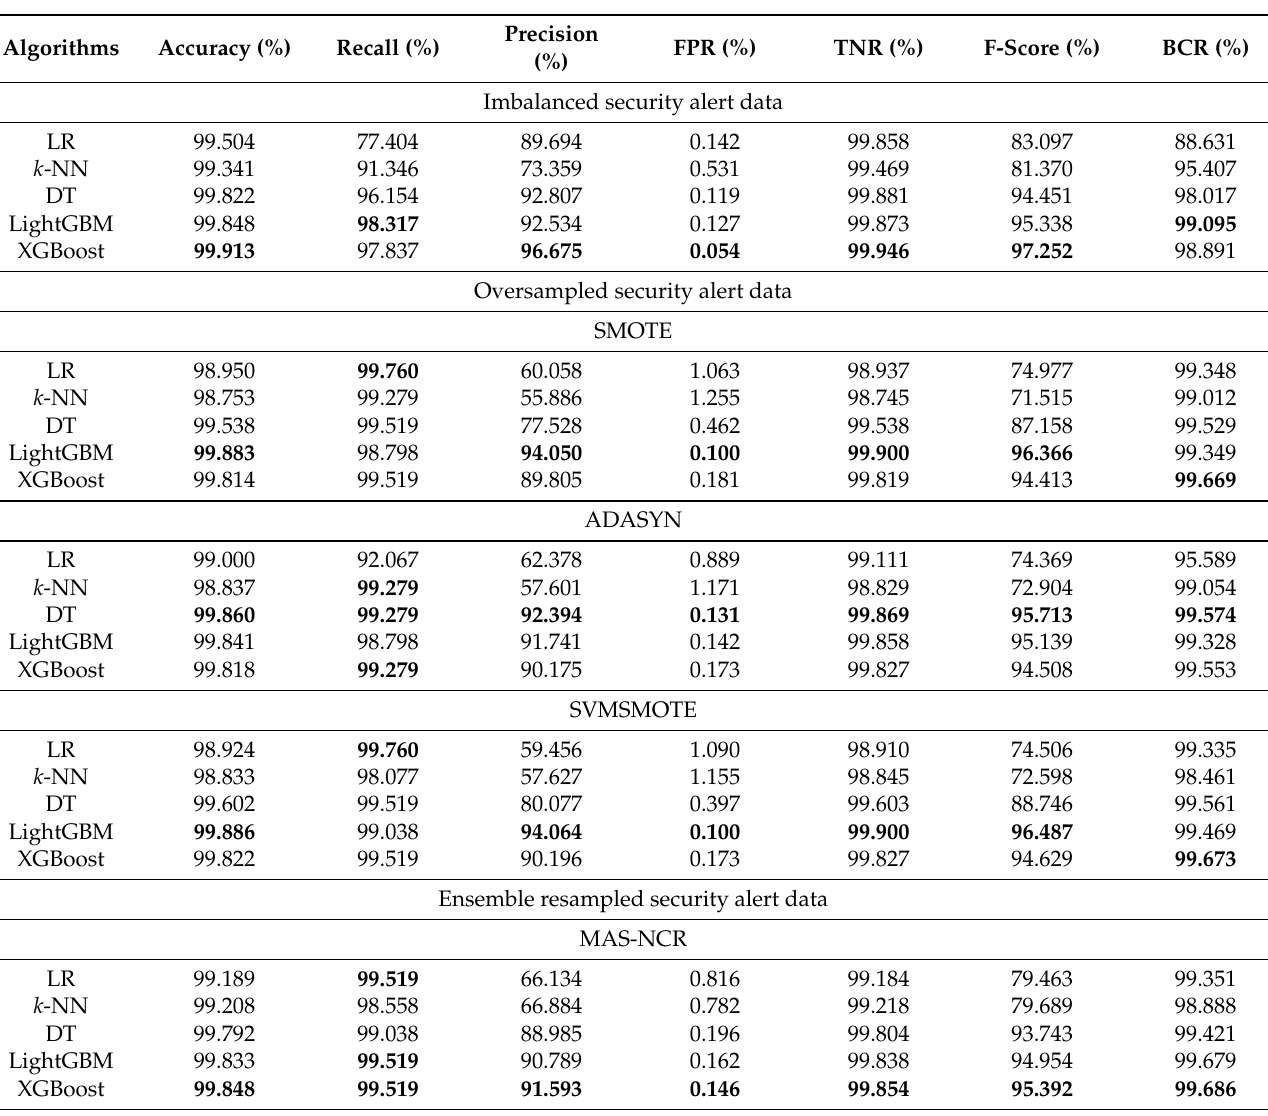
Table 4. Performance evaluation with different sampling settings on enterprise